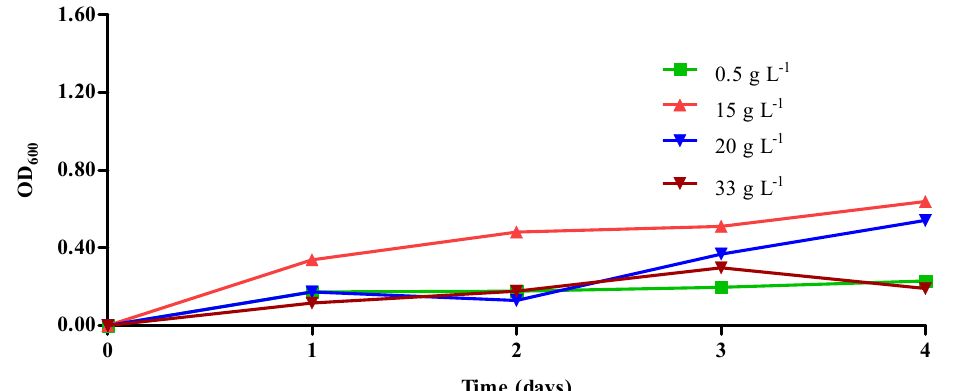
Figure 1. Growth of Citrobacter sp. D2 under different salinity conditions in the presence of 150 mg L − 1 of phenanthrene.